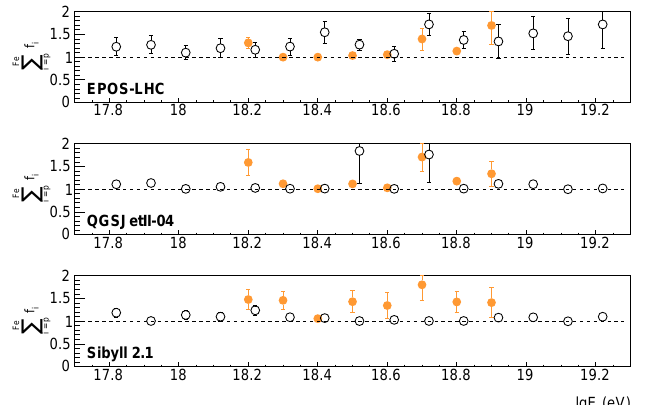
Figure 5. The sum of all reconstructed fractions obtained with method #2 (see text) as a function of en- ergy for EPOS-LHC ( up ), QGSJETII-04 ( middle ) and Sibyll 2.1 ( bottom ) hadronic interaction